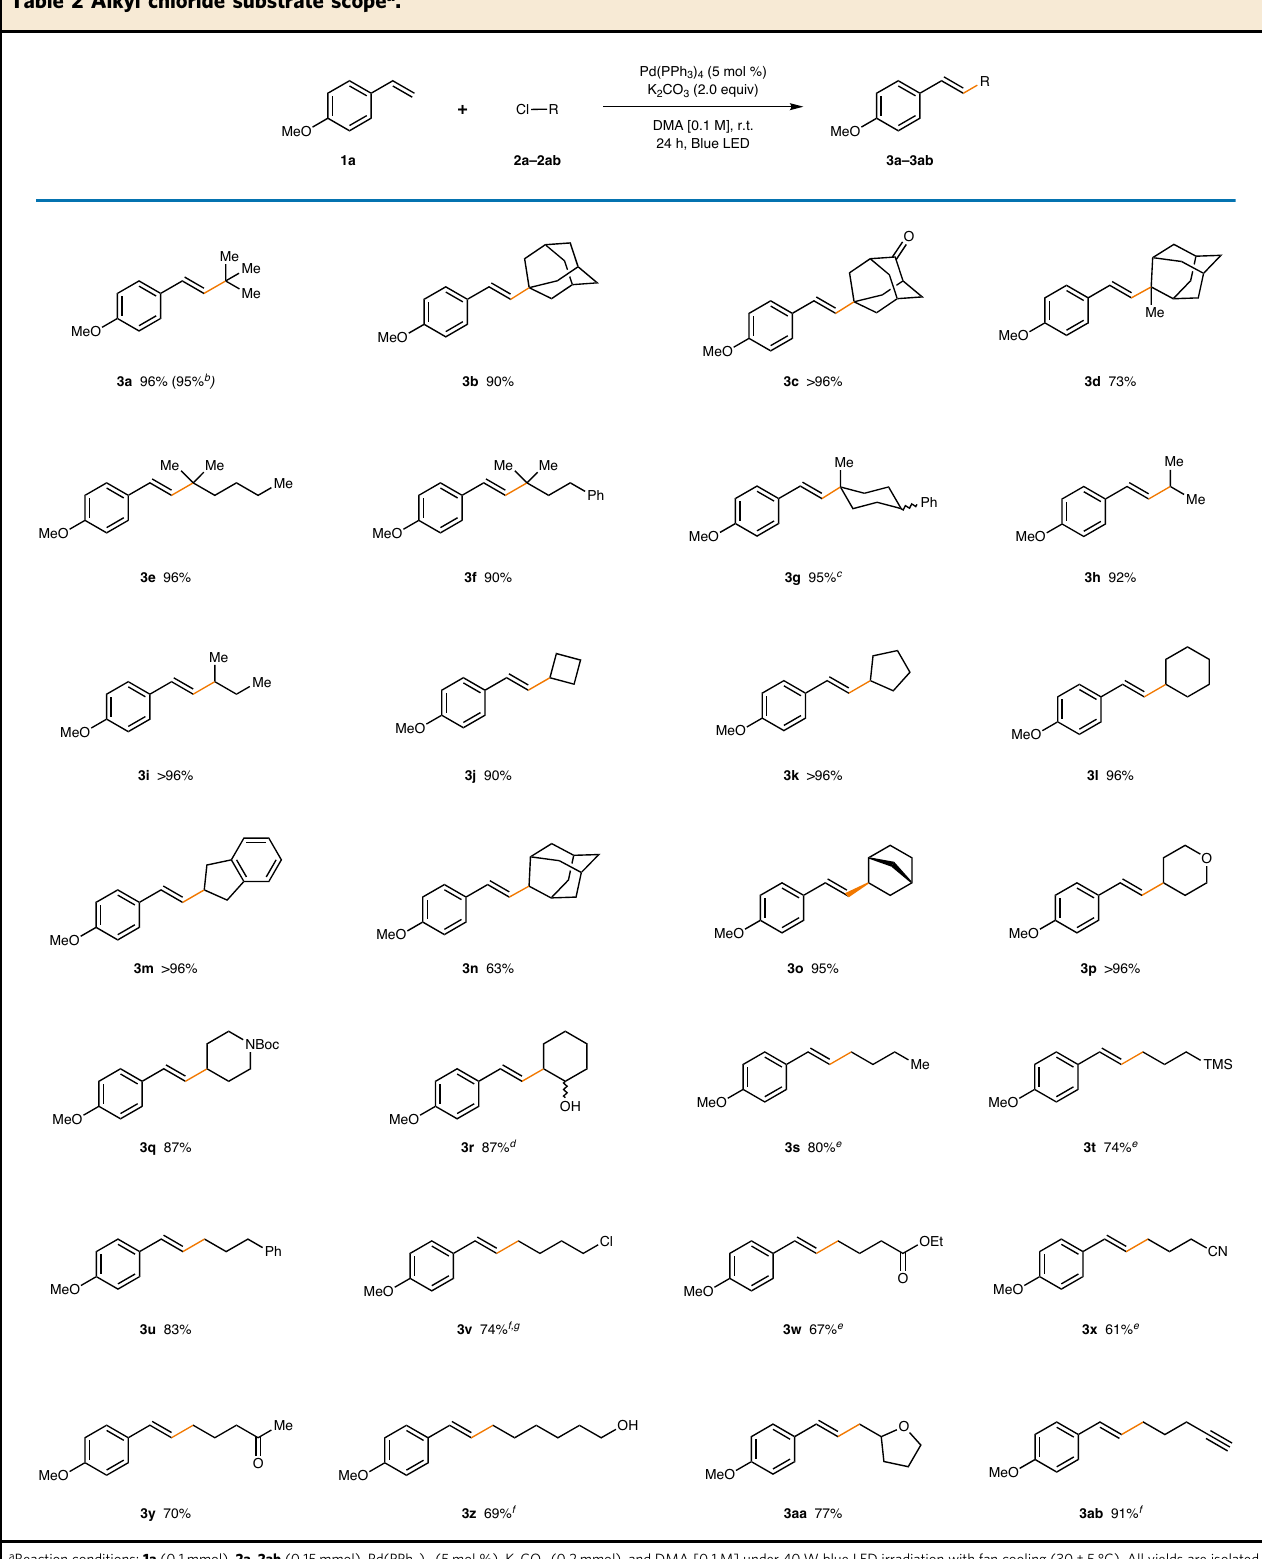
Table 2 Alkyl chloride substrate scope a